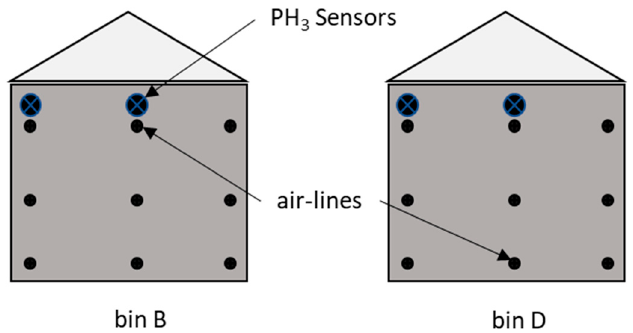
Figure 3. Schematic side-view of two grain bins and the locations of the four wireless phosphine sensors compared to the air sampling sensors compared to the air sampling locations.